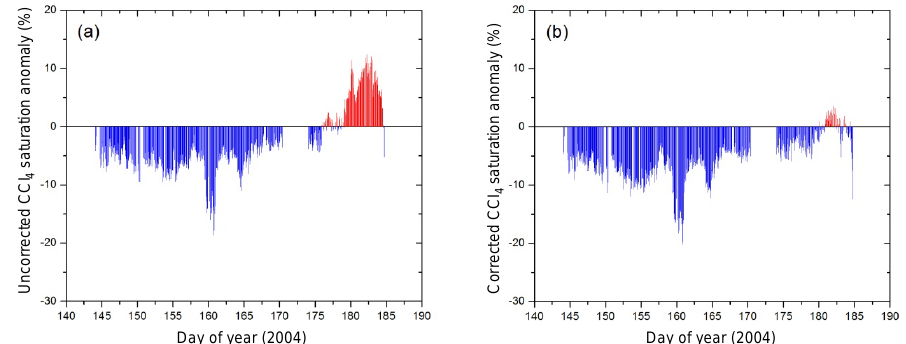
Figure 4. Observed (a) and corrected (b) CCl 4 saturation anomalies, central and NE Pacific, show the influence of physical processes on the observed values. Corrected saturation anomalies were derived by subtracting the observed anomalies of the largely unreactive gas of similar properties, CFC-11. Negative saturation anomalies are indicated with blue lines, positive with red lines.